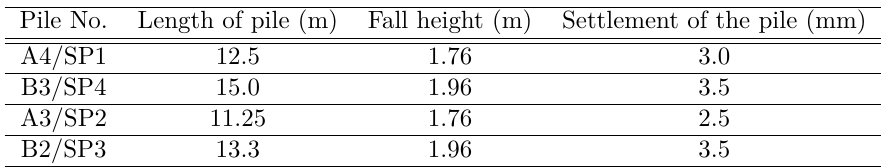
Table 1. Permanent settlement of test piles after 5 blows with a load.